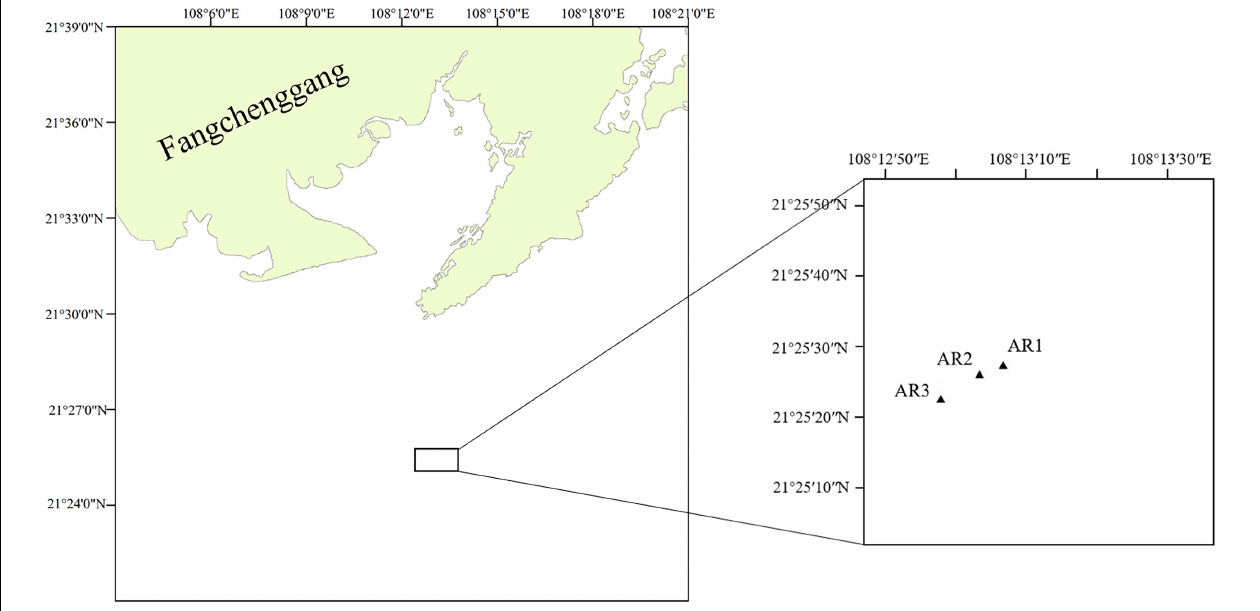
According to Figure 3 , the Shannon index of protists in the ARs and WAR showed a decreasing trend in the vertical